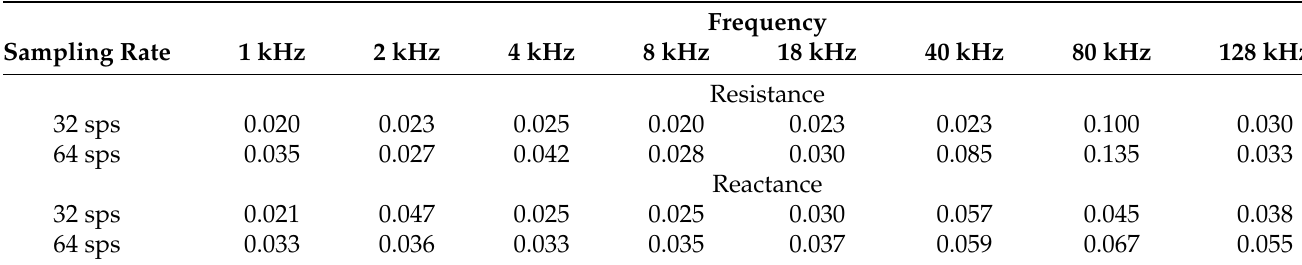
Table 4. Standard deviation of the resistance and reactance measurements of the 2 R − 1 C model by the MAX3000x in the 32 and 64 sps sampling